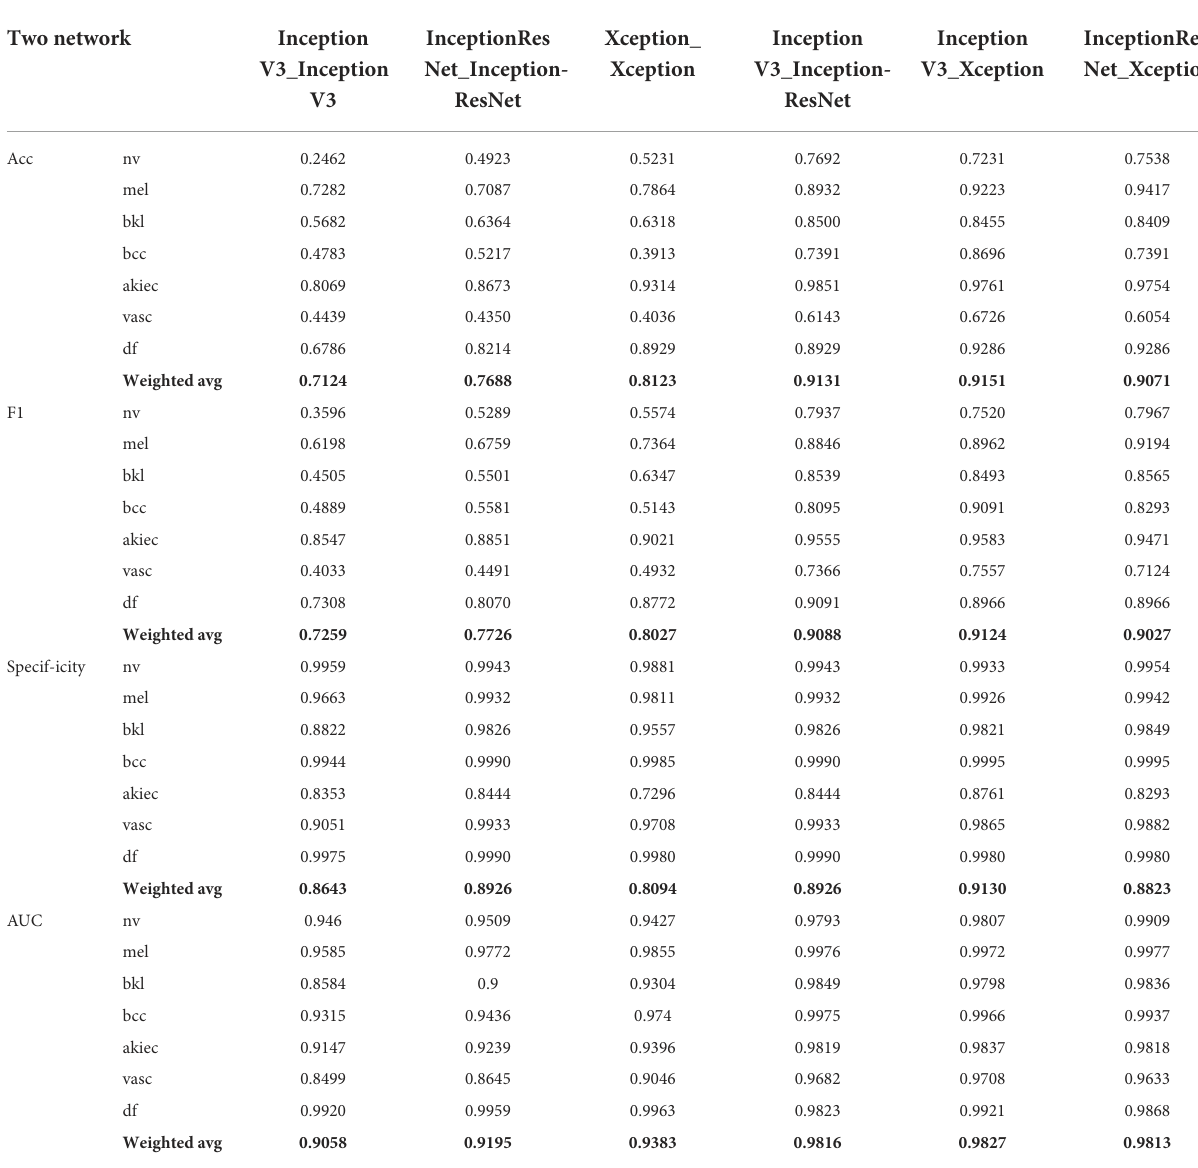
TABLE 6 The influence of fusion of two base classifiers on evaluation